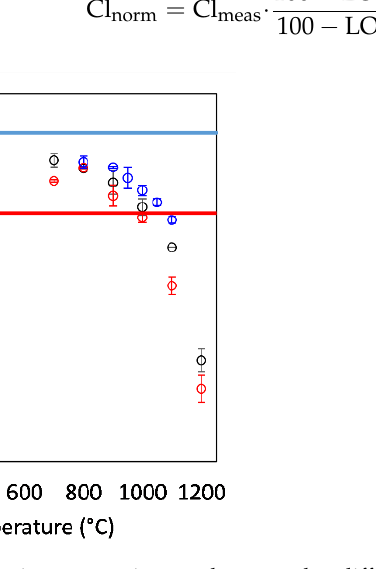
Figure 1. Variation in chlorine content in samples treated at different temperatures. The blue line and the red line correspond to the expected chlorine content for CaCl 2 and CaCl 2 · 2(H 2 O), respectively. LoI T is the loss of ignition for the calcined sample at temperature